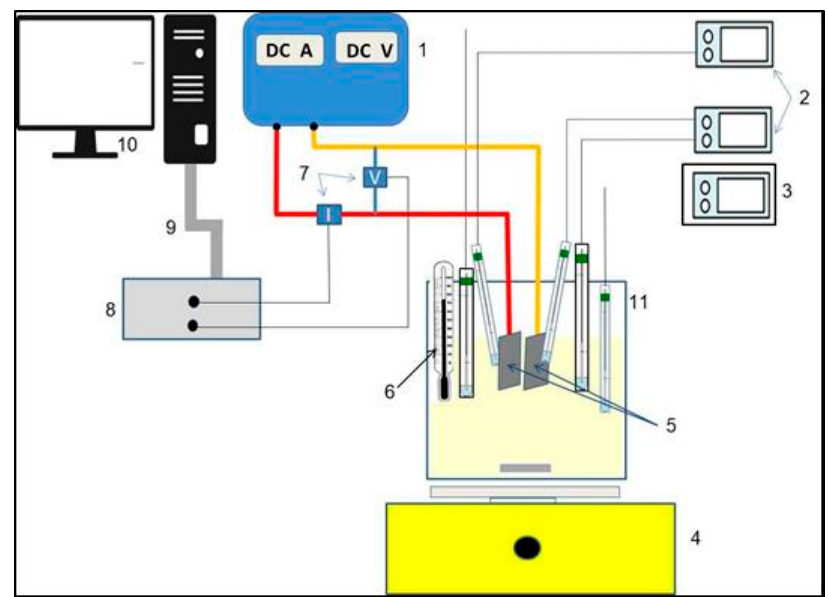
Figure 1. Diagram of the experimental setup. 1. Kaselco EC Equipment 2. pH and conductivity meters, 3. pH meter 4. Magnetic stirrer 5. Al Electrodes 6. Thermometer 7. Hall effect sensors 8. Signal conditioning 9. Cable for data acquisition 10. Data acquisition system 11. Benchmark reactor.